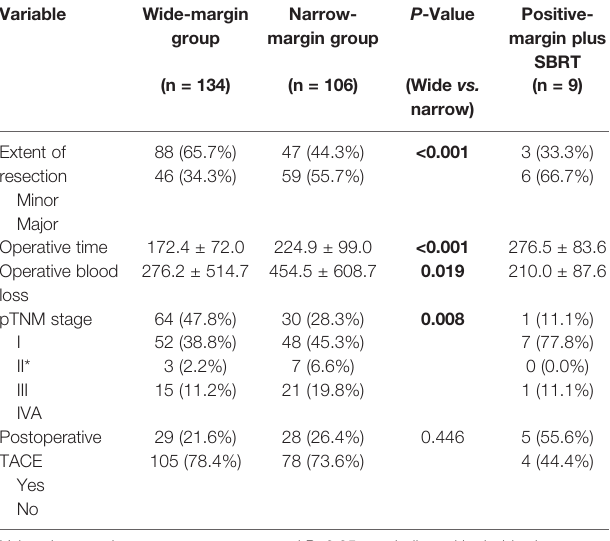
5 cm vs . > 5 cm) (Figure 4) . The 1-, 2-, 3-year RFS rates for patients receiving TACE were 69.7, 51.8, 44.7%, respectively, comparing to 68.9, 59.1, 51.7% accordingly in the no adjuvant TACE group ( Supplementary Figure 1 ).